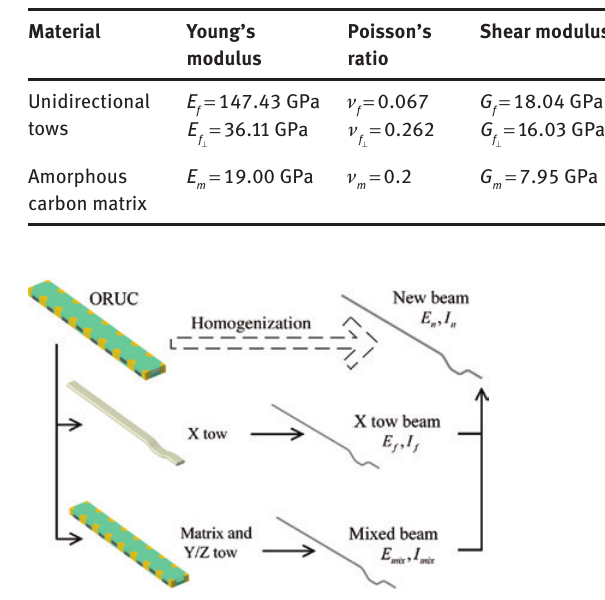
Figure 7: Simplification of tows and matrix support in longitudinal tensile loading.